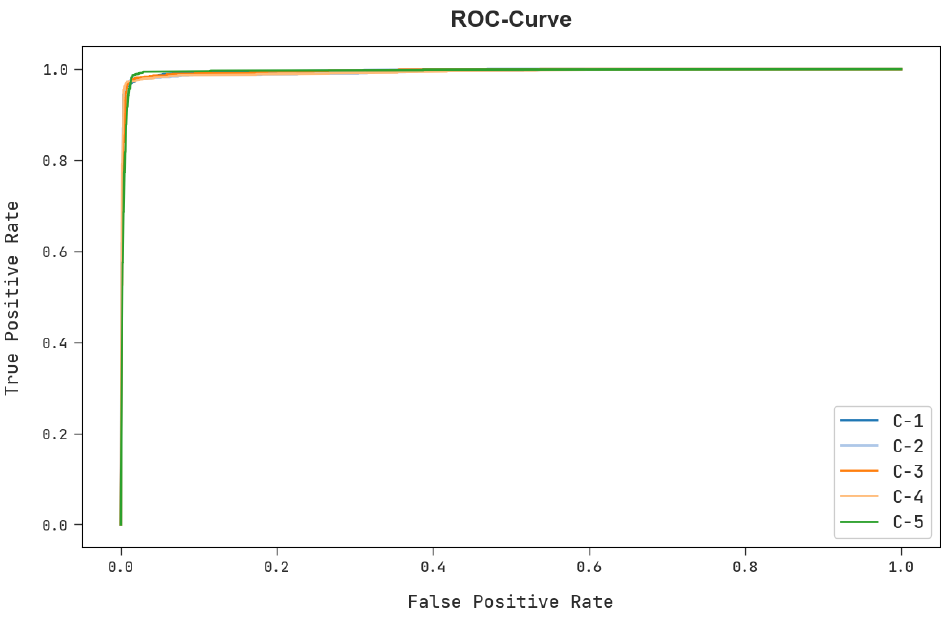
Figure 8. ROC curve analysis of AOEDBC-DL system.